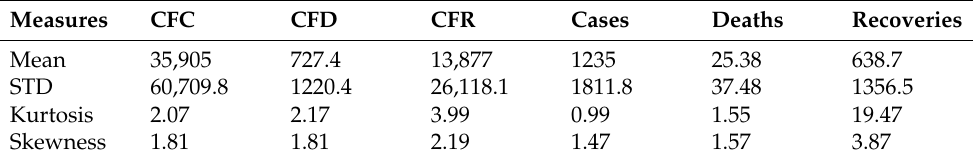
Table 2. The descriptive statistics of the considered datasets.